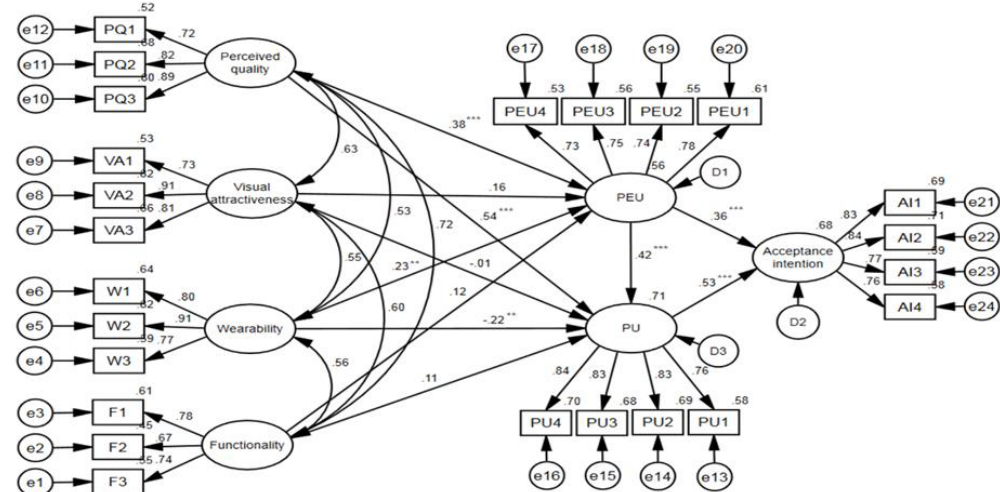
Figure 2. Acceptance intention prediction model for Taekwondo electronic protection devices. Note: *** p < 0.001, ** p < 0.01, PQ = perceived quality, VA = visual attractiveness, W = wearability, F = functionality, PEU = perceived ease of use, PU = perceived usefulness, AI = acceptance intention.